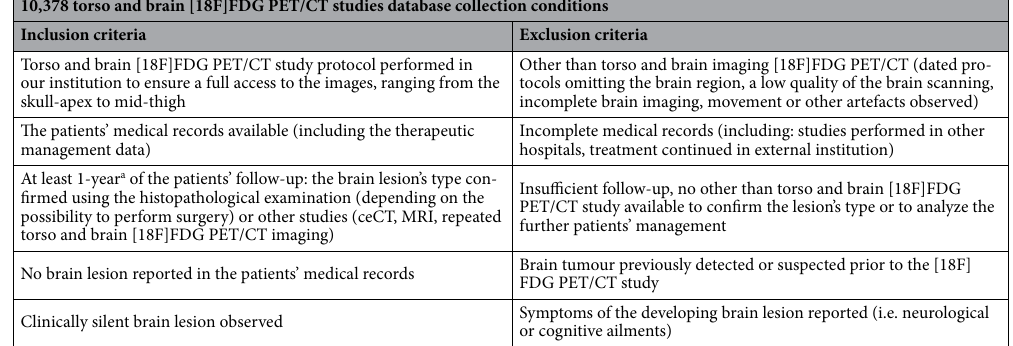
Table 2. 10,378 studies collection conditions: inclusion and exclusion criteria ( source: original data). a Range: 1–4 years of